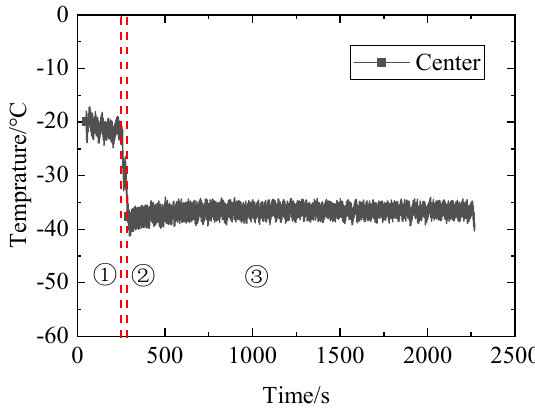
Figure 12. Temperature change curve with time under 850 W/m 2 heat flux.